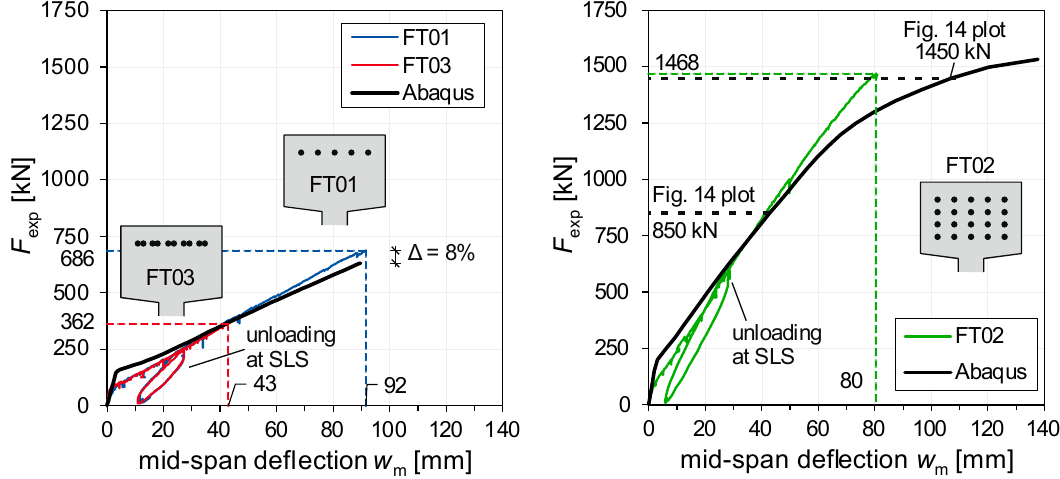
Figure 13. Load-deflection-behavior of I-beams and results of numerical Figure 13. Load ‐ deflection ‐ behavior of I ‐ beams and results of numerical calculation.